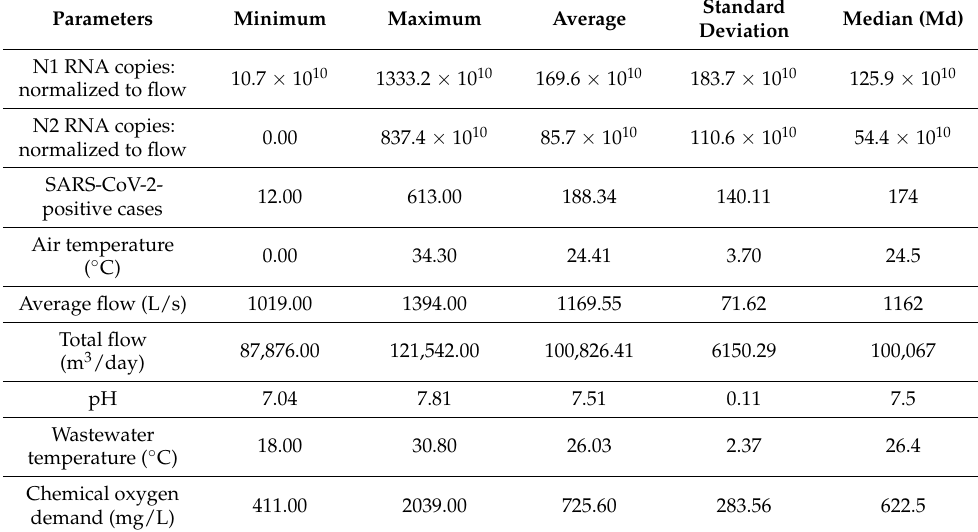
Table 1. Parameters of wastewater samples collected and SARS-CoV-2 RNA quantification using N1 and N2